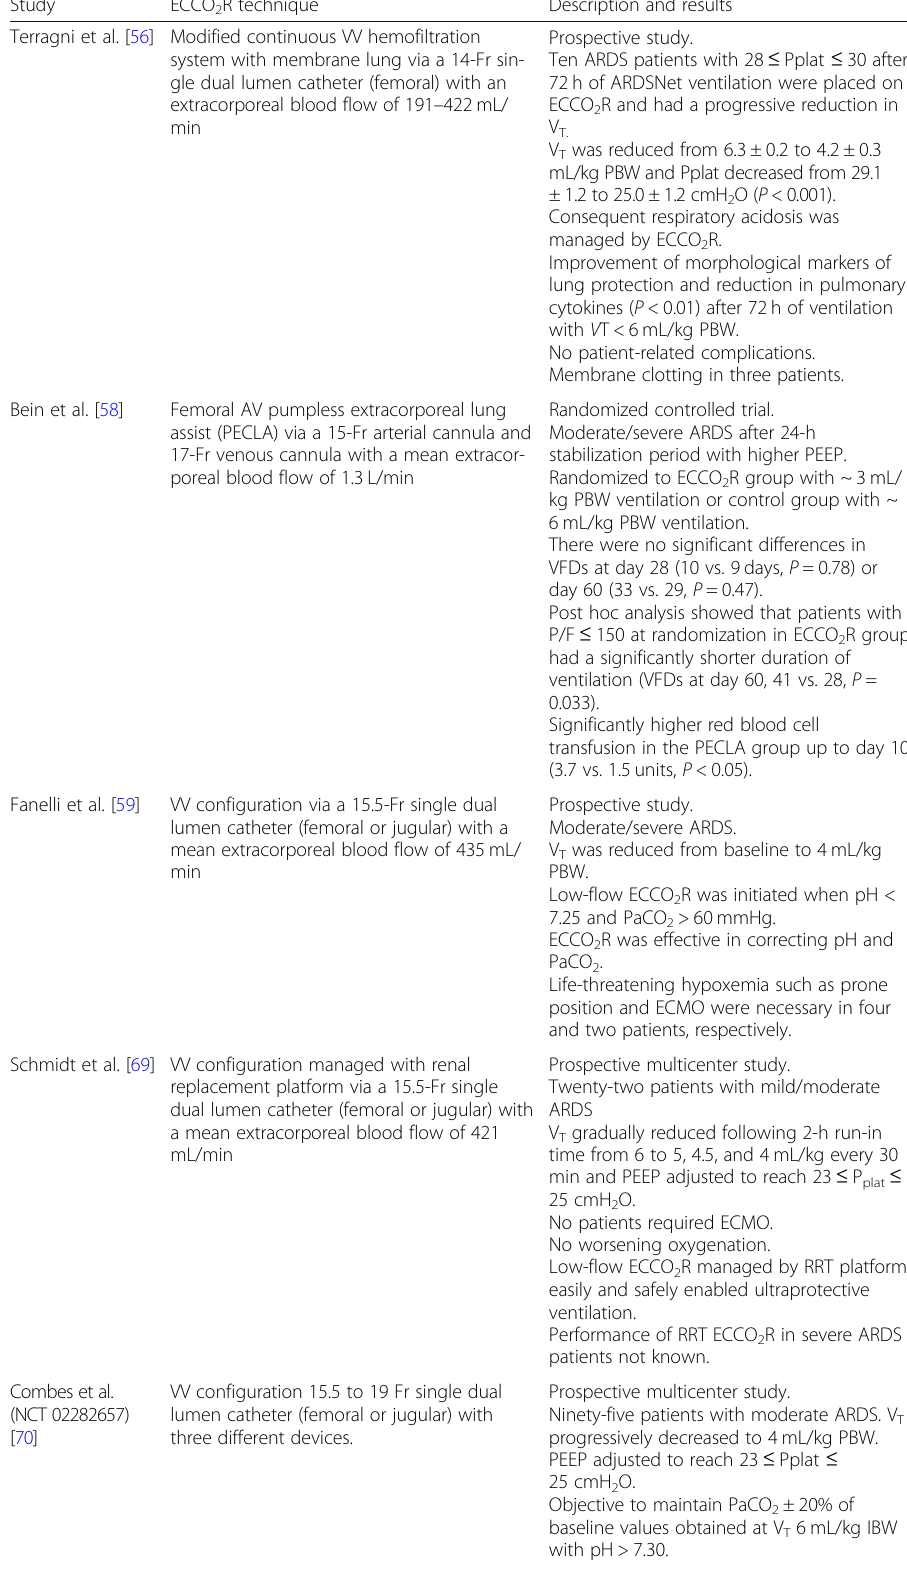
Table 4 Relevant clinical studies of ECCO 2 R in ARDS patients Study ECCO 2 R technique Description and